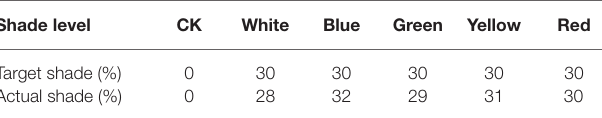
TABLE 1 | Actual and target shade readings (%) for control (CK), white, blue, green, yellow, and red photo-selective netting. Shade